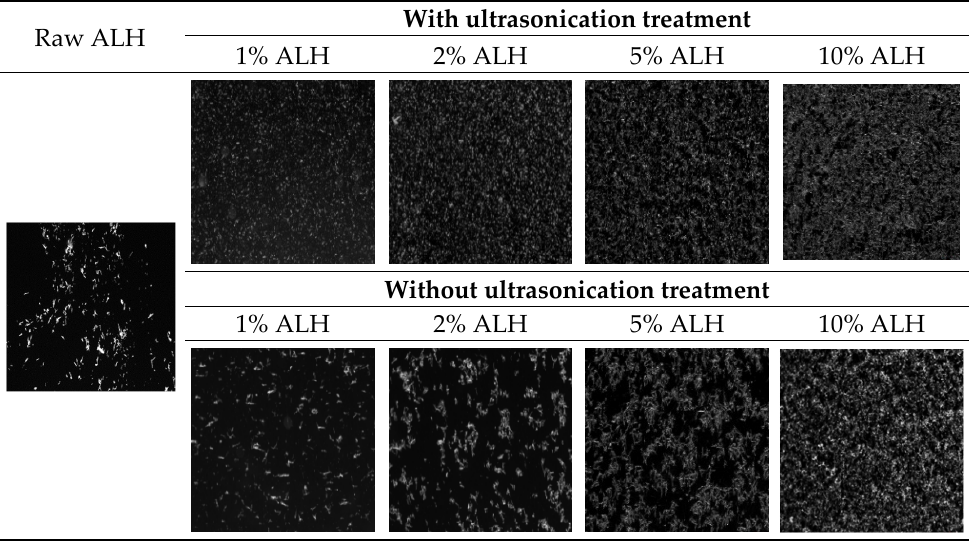
Figure 5. Dissolution profiles of raw ALH (( A ) 30 mg ALH; ( C ) 150 mg ALH) and ALH-loaded Su- SNEDDS (( A ) 1% ALH-loaded; ( B ) 2% ALH-loaded; ( C ) 5% or 10% ALH-loaded) prepared from F3, F6, F9, and F12 in 1% SLS pH 1.2 buffer. Vehicle composition F3, F6, F9, and F12 are from Table 2.